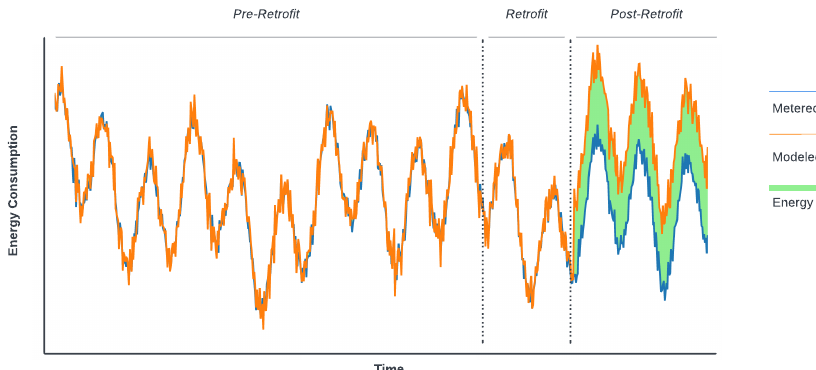
Figure 1. Actual energy consumption and modeled building baseline vs. time.